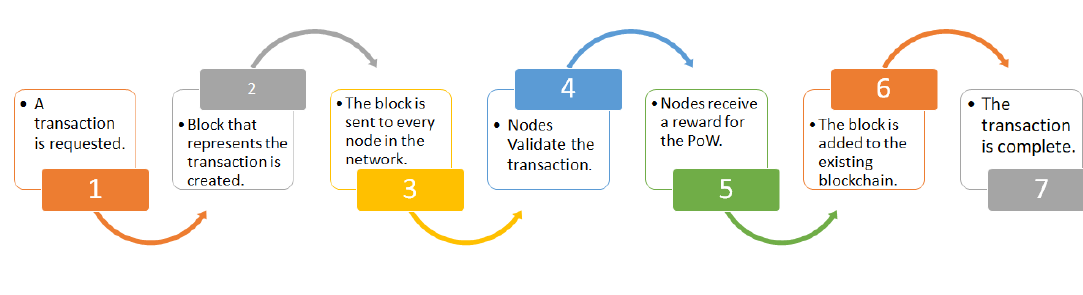
Figure 1. Blockchain process.